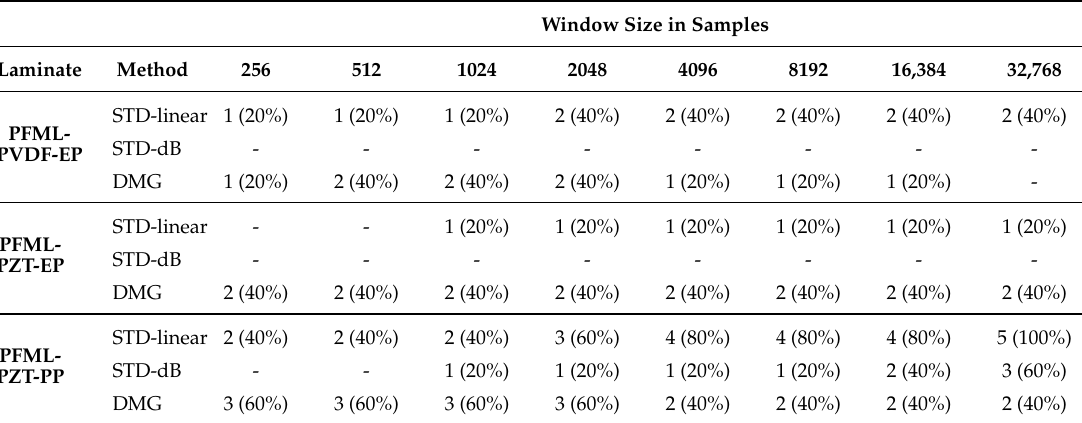
Table 6. Analysis results for trend formation detection by the standard deviation of the SED (STD) and the damage index (DMG) as a function of scaling and measuring window size or the amount of specimens (numbers in brakes show the retaliative quantity of